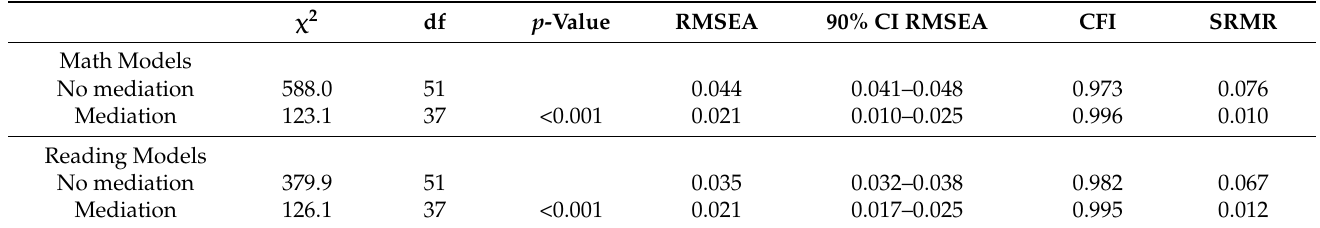
Table 3. Model fits.